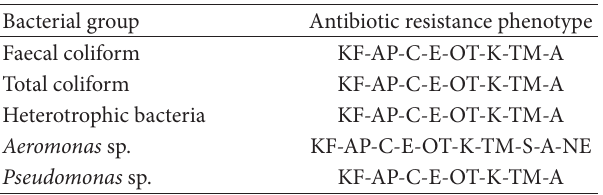
Table 9: Prevalent antibiotic resistance phenotypes observed amongst the bacterial groups.